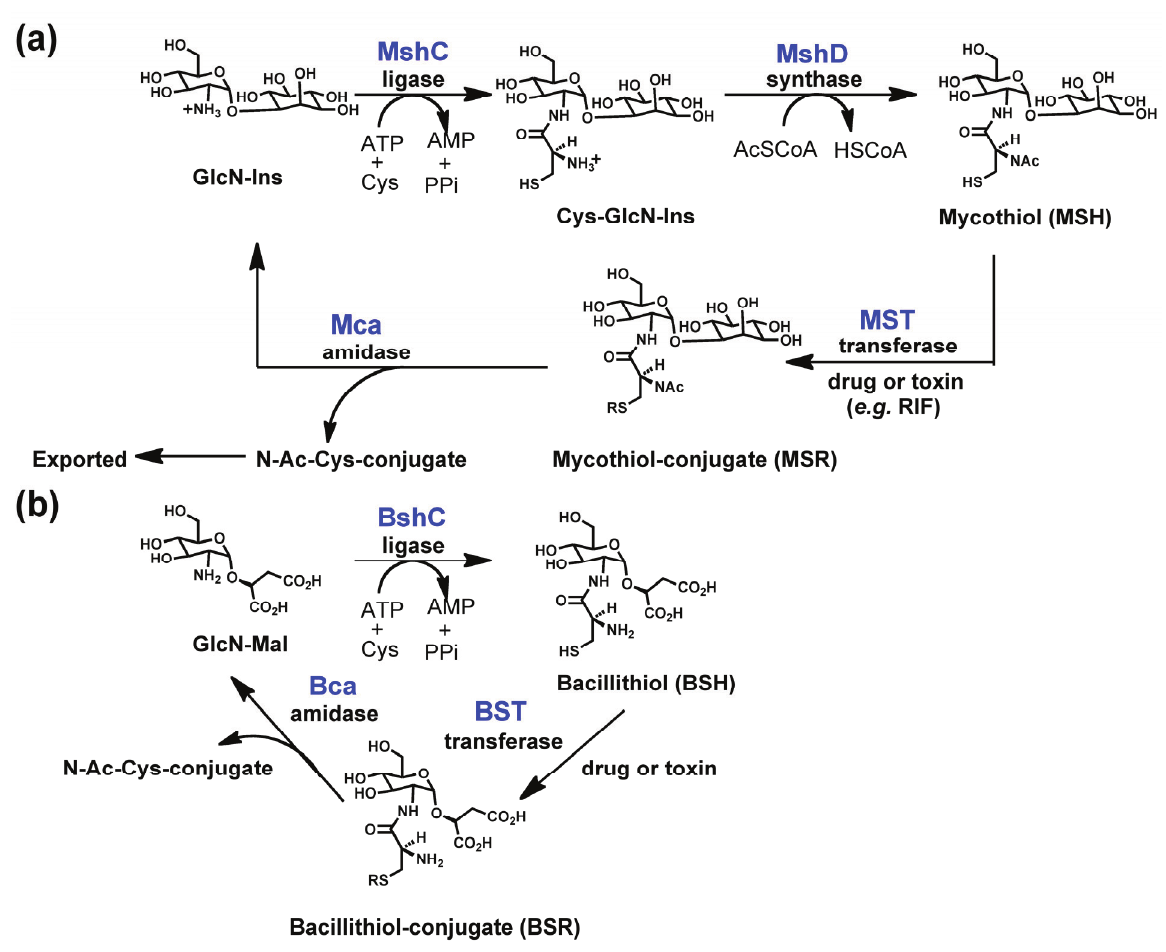
Figure 3. Electrophilic xenobiotic detoxification by ( a ) MSH and ( b )